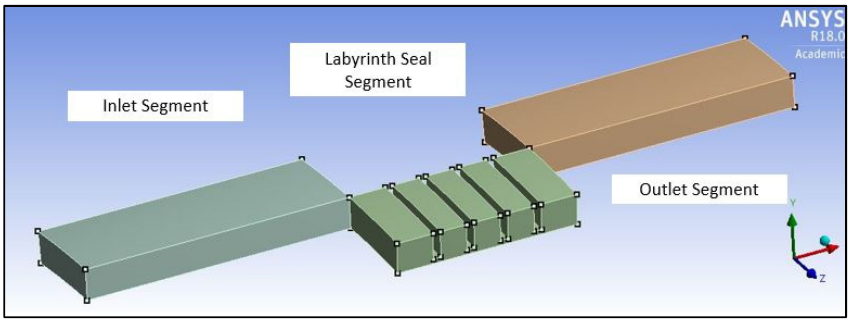
Figure 2. Considered setup with stator labyrinth teeth.